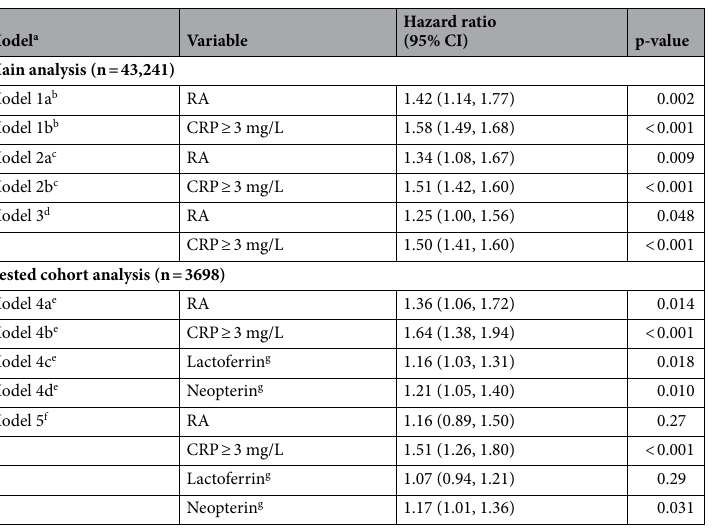
Table 2. Cox regression models for all-cause mortality. CI, confidence interval; CRP, C-reactive protein; RA, rheumatoid arthritis. a All models accounted for differences in age by using age as the time variable, and allowed for different baseline hazards in men and women by stratification on sex. b Models 1a and 1b included either RA or CRP, respectively. c Models 2a and 2b included either RA or CRP and additional adjustments for body mass index, diabetes, hypertension, smoking, and total cholesterol. d Model 3 included RA and CRP and the adjustments mentioned above. e Model 4a, 4b, 4c, and 4d, included either RA, CRP, Lactoferrin, or Neopterin, respectively. f Model 5 included RA, CRP, Lactoferrin, and Neopterin, and the